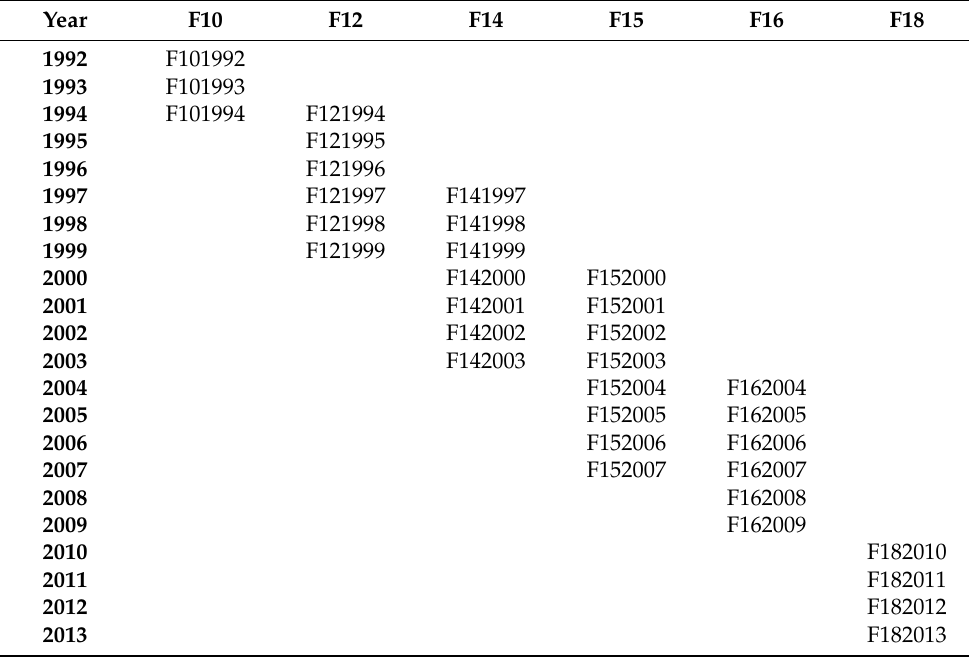
Table 2. The DMSP/OLS satellites and their overlays in the corresponding years.